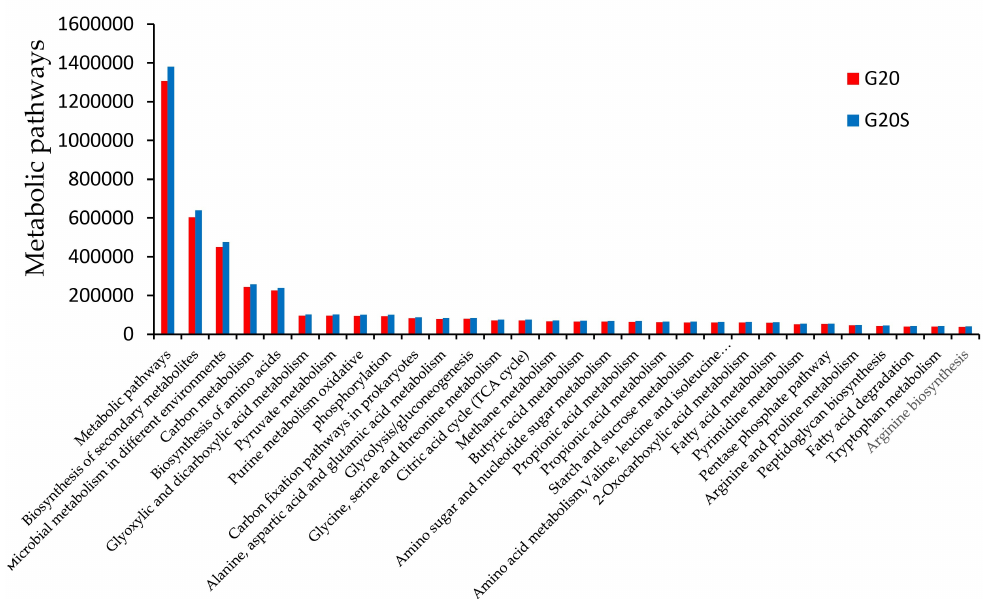
Figure 6. Abundance map of the top 30 tertiary metabolic pathways annotated by KEGG between the G20 (noninoculation) and G20S (strain SR-9 inoculation)